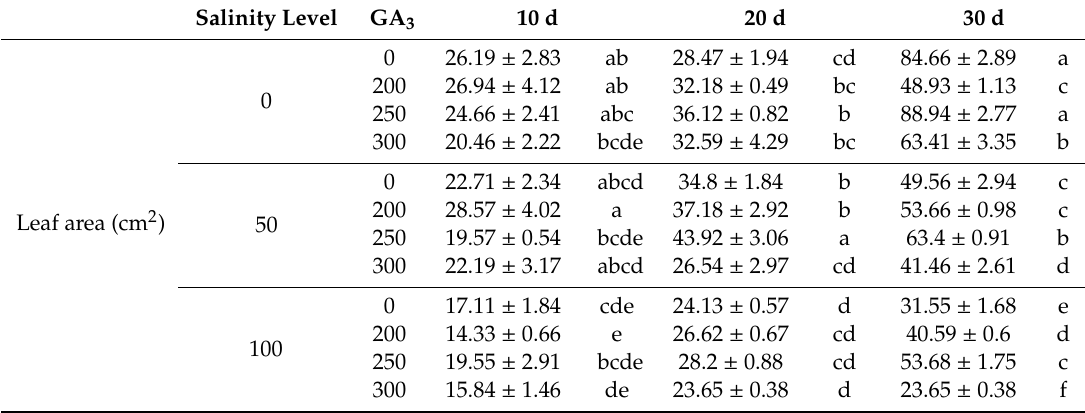
Table 3. E ff ects of di ff erent levels of exogenous GA 3 on leaf area of caster bean seedlings grown under three levels of NaCl treatment: 0 (control), 50, and 100